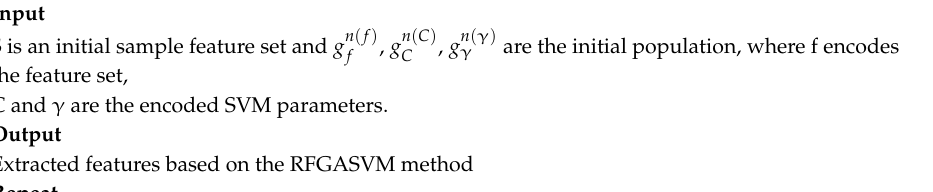
Algorithm 1. Flow of the proposed feature selection method.